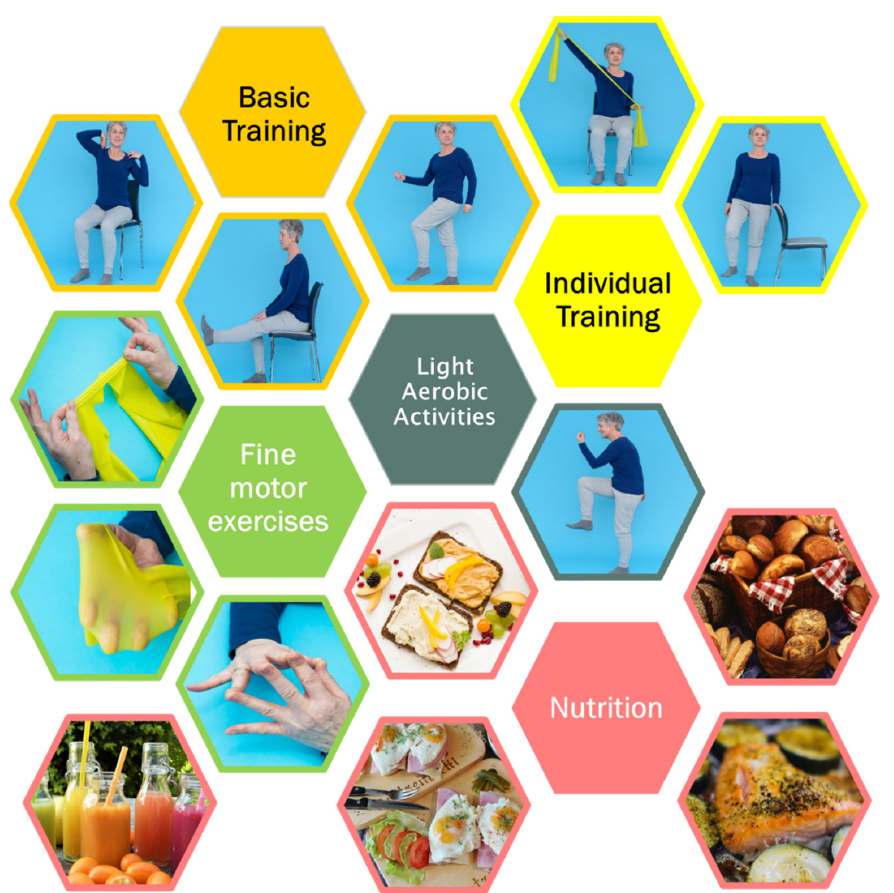
Figure 1. Exemplary elements of the physical activity program and dietary recommendations.